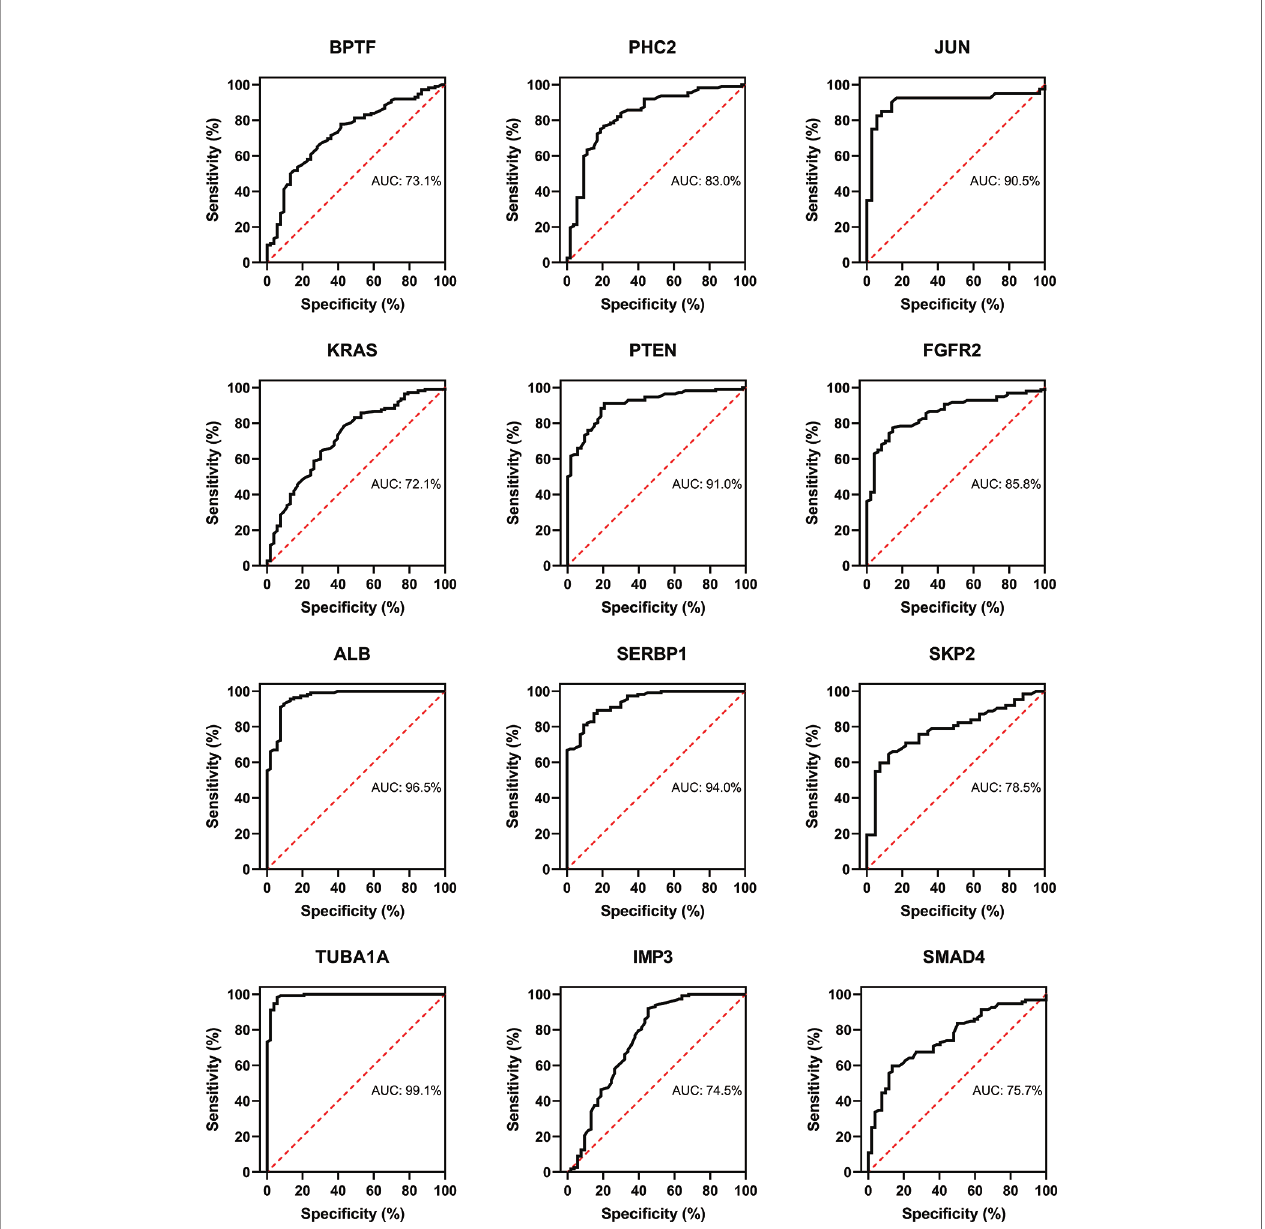
FIGURE 11 | Con fi rmation of RA hub genes by ROC analysis. Out of 30 genes of immune cells fi ltered by MCODE, 12 genes having AUC > 0.70 were identi fi ed as biomarker genes for